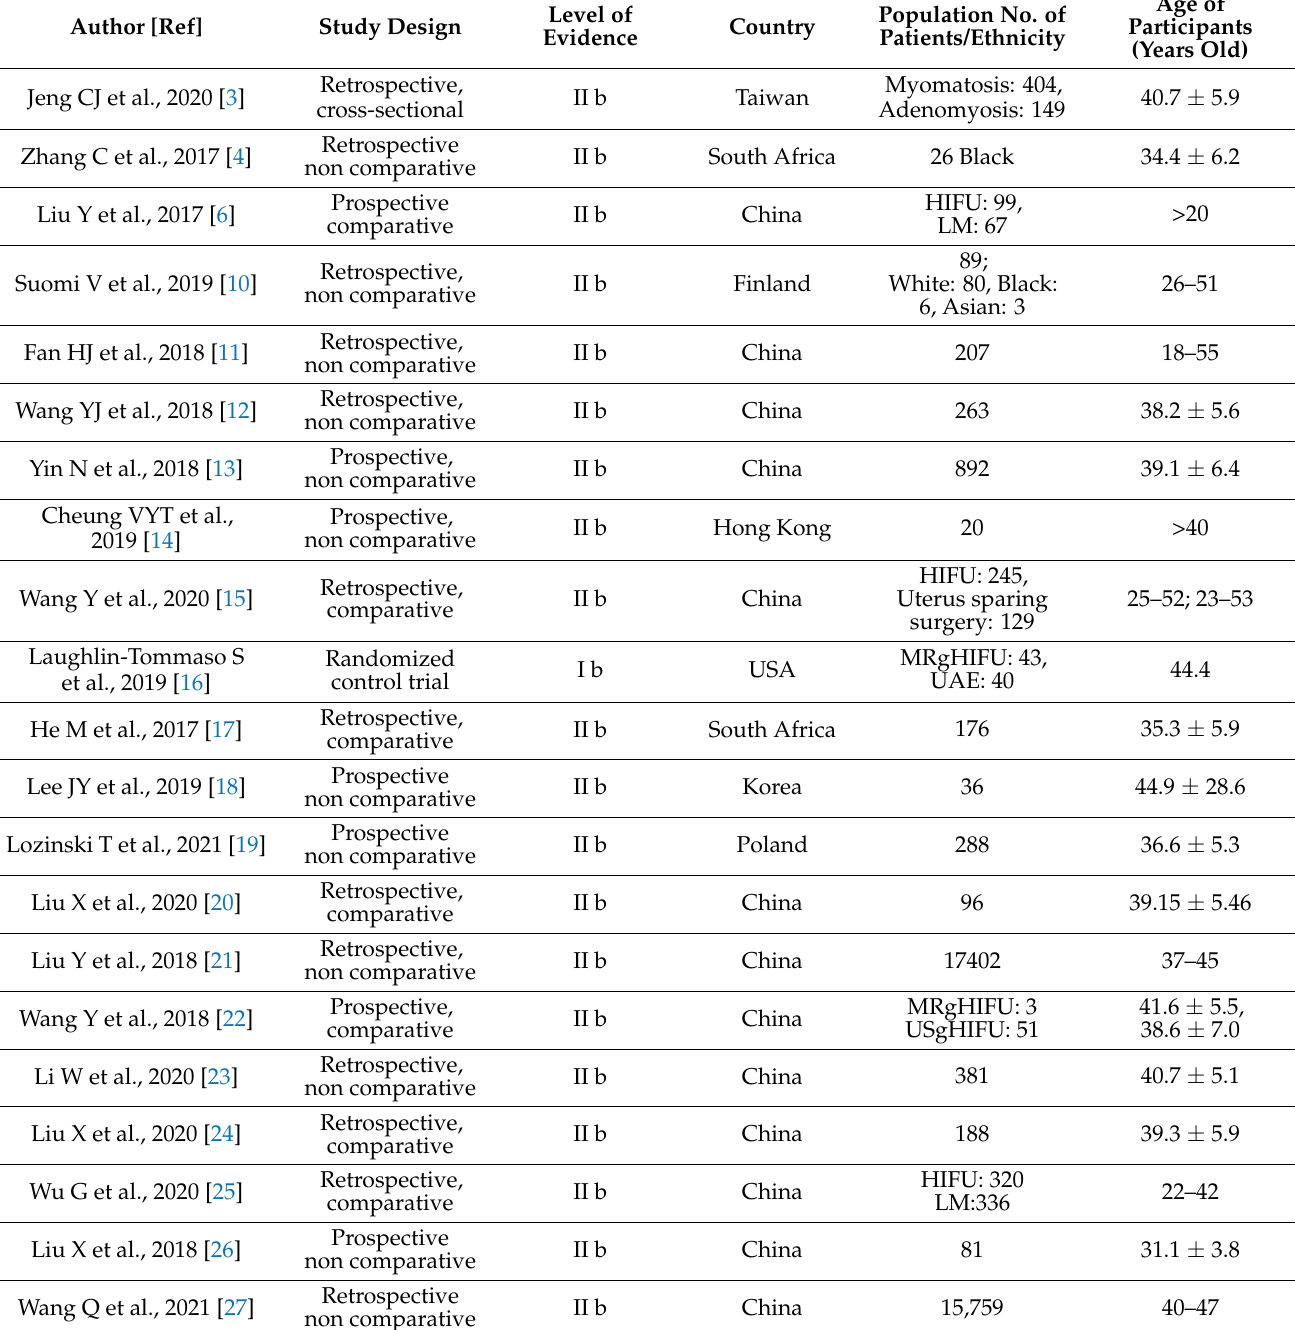
Table 1. Characteristics of the studies about HIFU included in this opinion